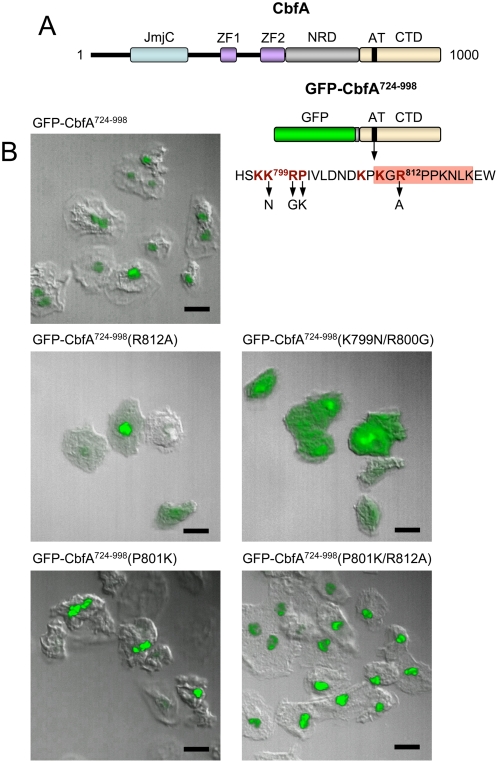
Nuclear localization of CbfA-CTD.(A) Schematic presentation of the CbfA protein. CbfA (1000 amino acids) contains the following domains: JmjC: jumonji domain; ZF: zinc fingers; NRD: asparagin-rich domain; AT: AT-hook; CTD: carboxy-terminal domain. GFP-CbfA724–998 represents a protein expressed from plasmid pPT132-CTD. The amino acid sequence surrounding the AT-hook is indicated. The AT-hook itself is indicated by the red box. Amino acids contributing to nuclear localization are written in red color and bold. Mutations introduced into the GFP-CbfA724–998 protein to test for nuclear localization and in vivo function of the AT-hook, respectively, are indicated below the arrows (see text for details). (B) Shown is the expression in JH.D cells of GFP-CbfA724–998 wildtype protein and mutants GFP-CbfA724–998(R812A), GFP-CbfA724–998(K799N/R800G), GFP-CbfA724–998(P801K), and GFP-CbfA724–998(P801K/R812A). Cells were fixed and analyzed by confocal laser scanning microscopy. Scale bar is 10 µm.